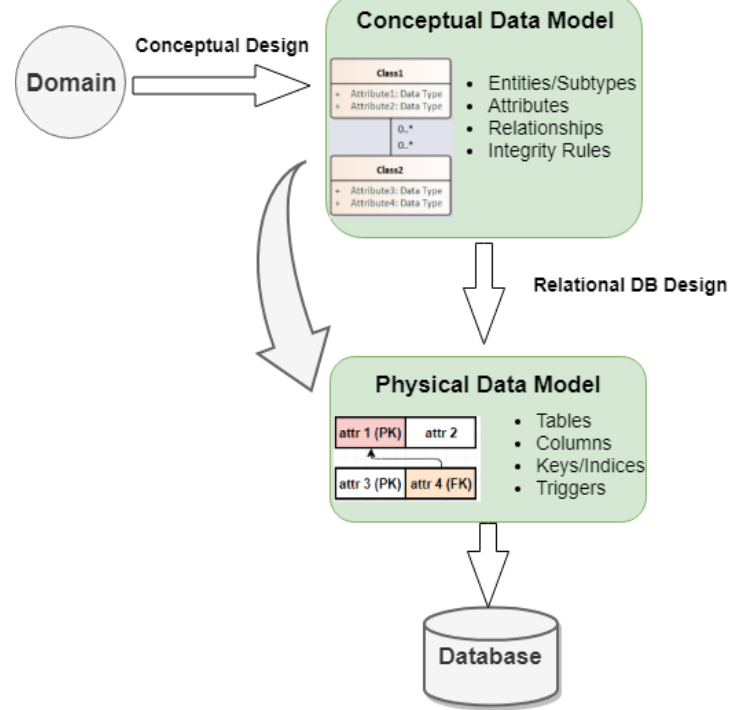
Figure 4. The process of data